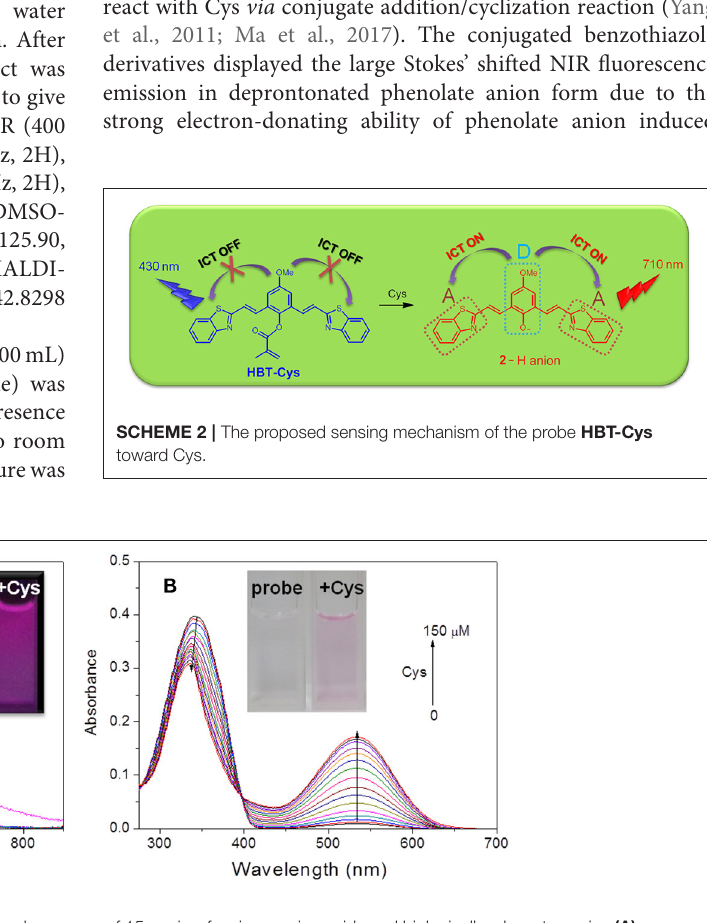
Frontiers in Chemistry |